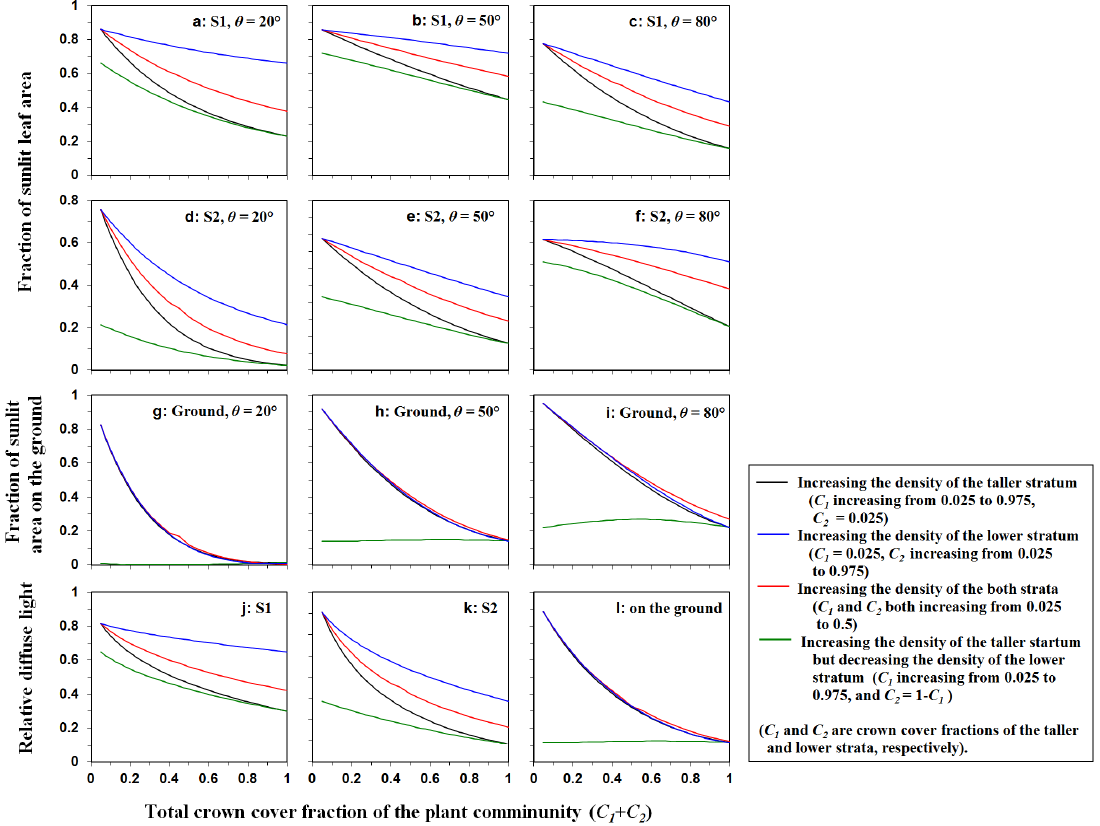
Figure 11. The sensitivity of the fractions of sunlit area (on the leaves and on the ground) and relative diffuse radiation to plant density for two-stratum plant communities (the taller stratum (S1): h 1 = 2m, H 1 = 10m, D 1 = 1m, LAI p1 = 3; the lower stratum (S2): h 2 = 0m, H 2 = 5m, D 2 = 1m, LAI p2 = 3). Plant density is expressed as crown cover fractions for both strata ( C 1 and C 2 ) , calculated by D 2 D 2 d 2 , respectively ( D 1 and D 2 is the widths of the crowns of the two strata, respectively, and d 1 and d 2 are the numbers of plants per square 2 metre for the two strata, respectively). The relative diffuse light is the ratio to the diffuse light on a horizontal surface above the